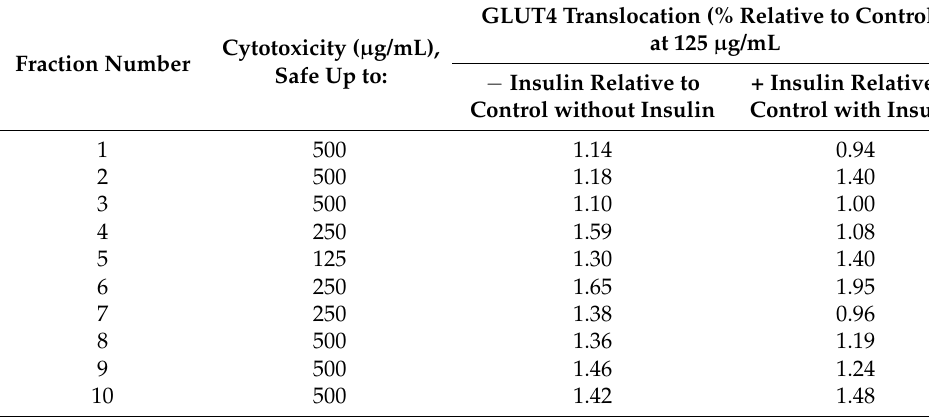
Table 3. Summary of the cytotoxicity and anti-diabetic activity of GT